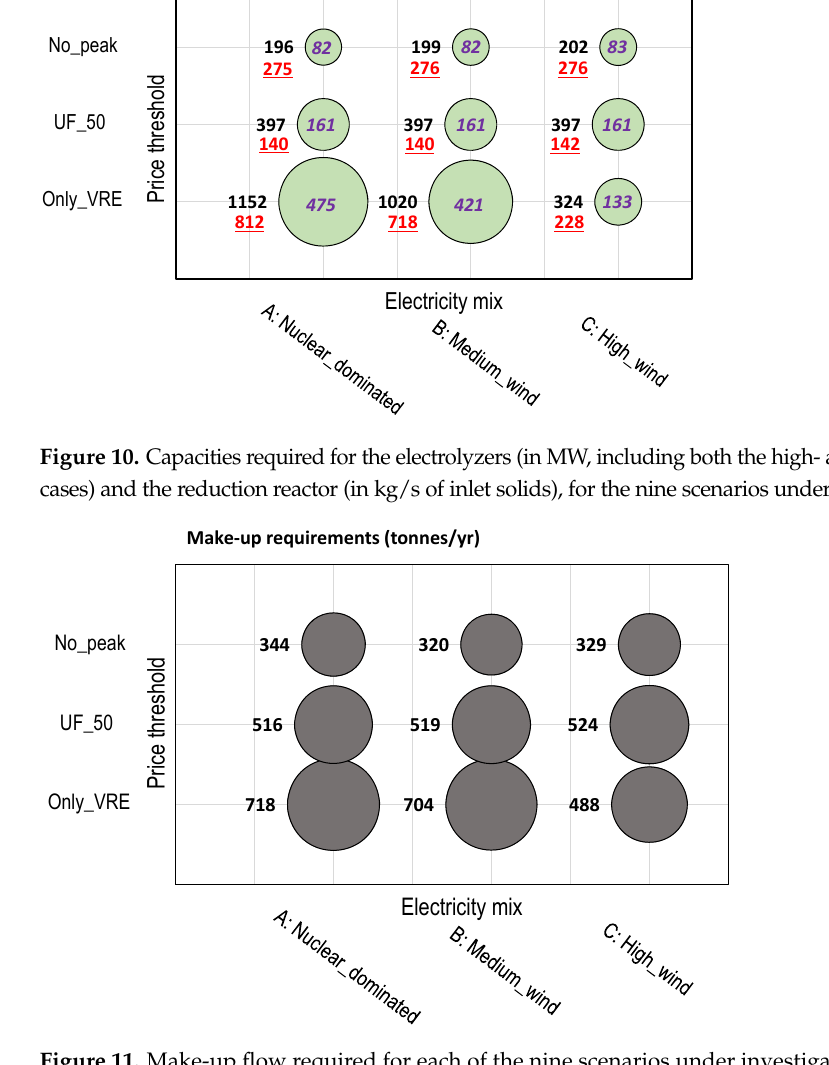
Figure 10. Capacities required for the electrolyzers (in MW, including both the high ‐ and low ‐ tempera ‐ ture cases) and the reduction reactor (in kg/s of inlet solids), for the nine scenarios under investigation.